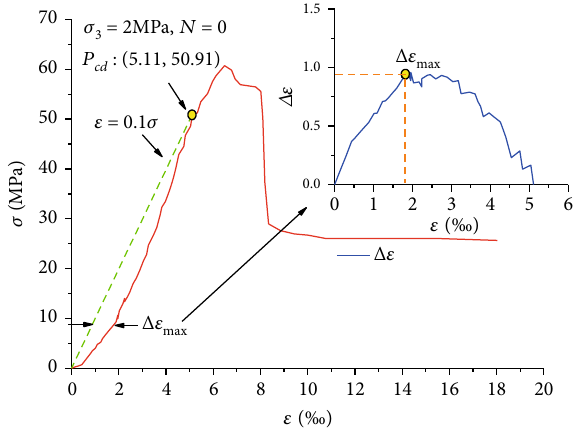
Figure 4: The axial strain response method to determine the crack closure stress σ cc